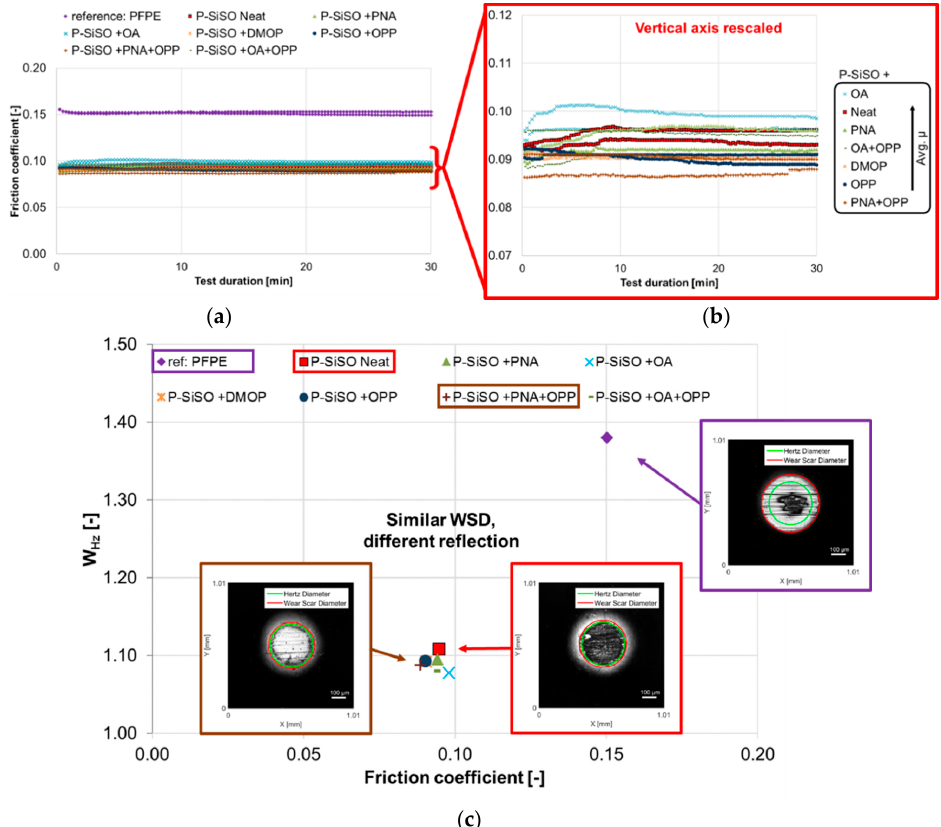
Figure 7. Results from the experiments at C{150 N/25 °C /30 min}. ( a ) Friction traces for the reference PFPE and P-SiSO with and without additives; ( b ) magnified friction traces of P-SiSO with and without additives; and ( c ) µ-W chart with insets of ball wear scars for PFPE, neat P-SiSO and P-SiSO with PNA + OPP additives, respectively.